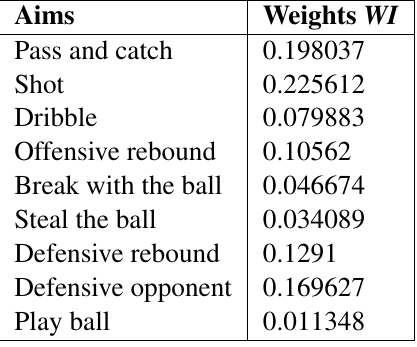
Table 8 Target weight calculation